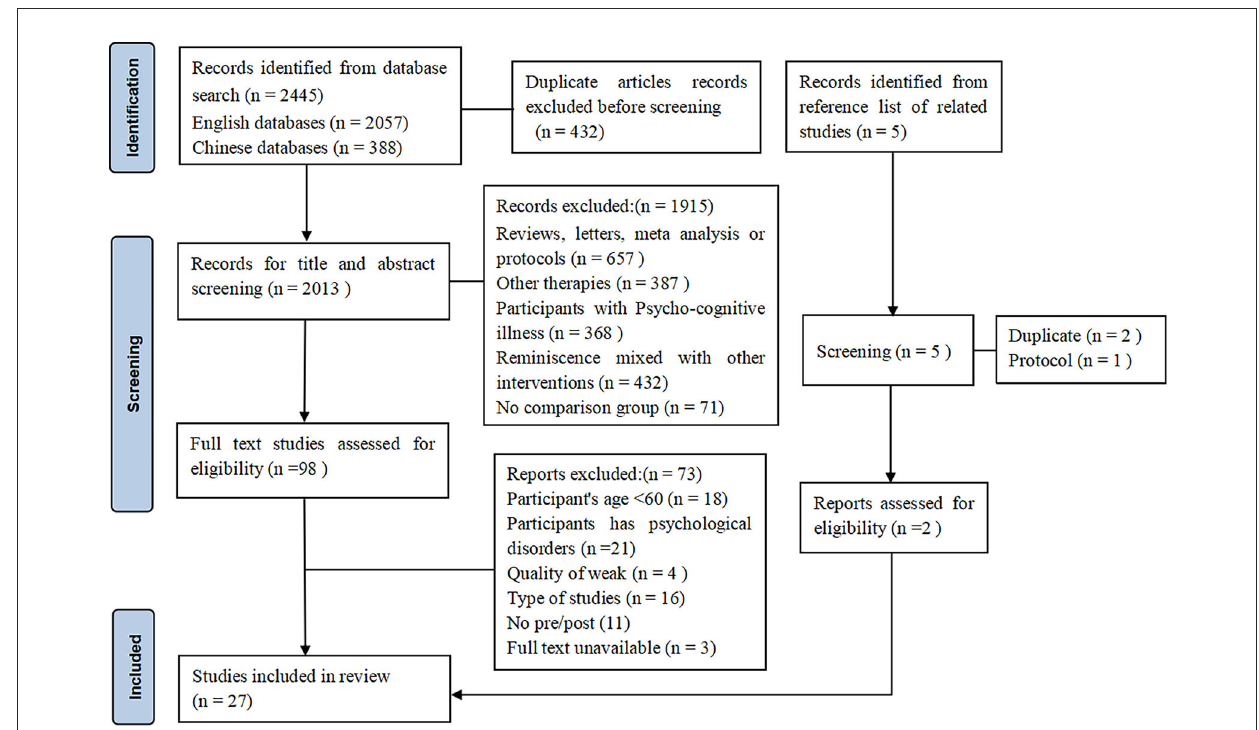
FIGURE1 PRISMA diagram summarizing the records retrieval and